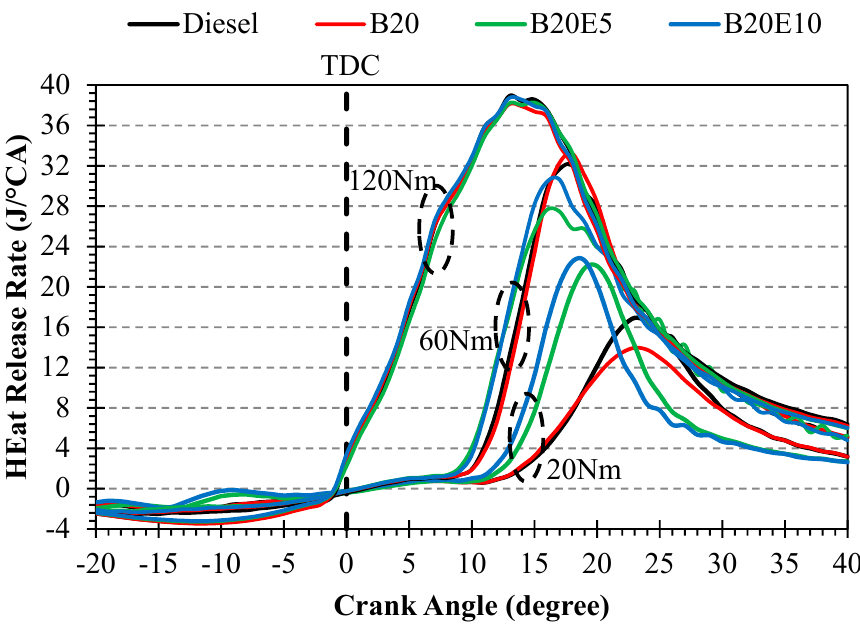
Figure 8. The variation in heat release rate for diesel, B20 and B20E5 at an engine load of 20 Nm, 60 Nm, and 120 Nm.